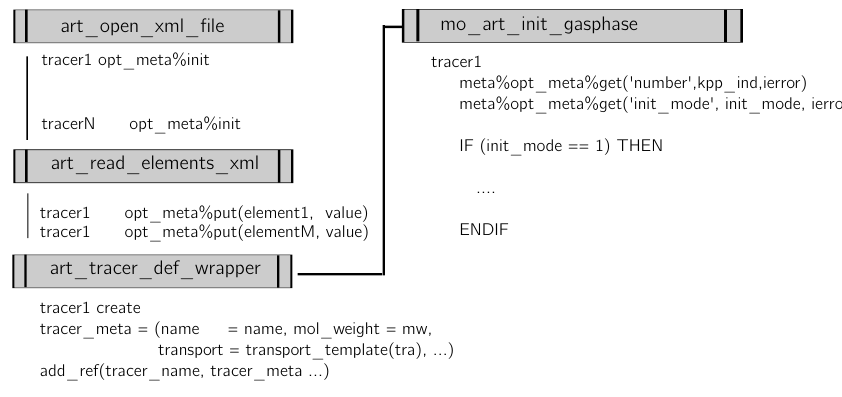
Figure 1. Schematic describing the tracer framework and the tracer definition in